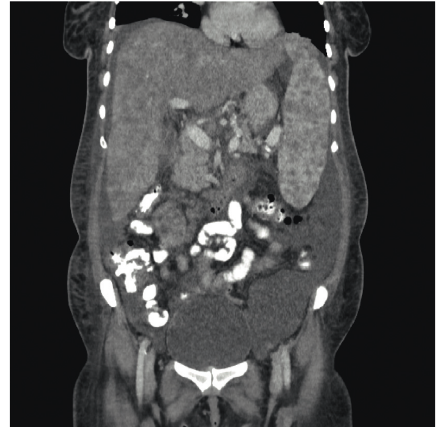
Figure 4: Computed tomography of the pelvis with contrast showing densities in the spleen.